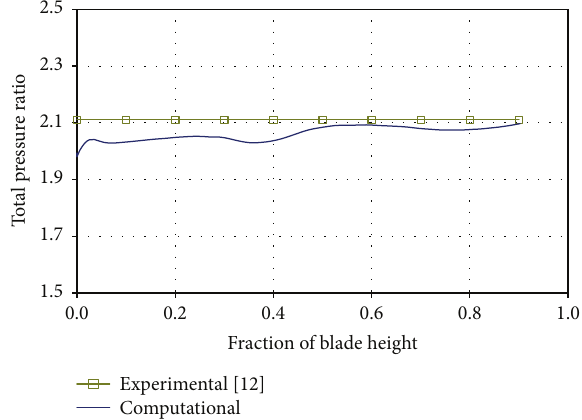
Figure 8: Radial variation of total pressure ratio across the rotor at 100% design rotational speed and comparison with experimental data of